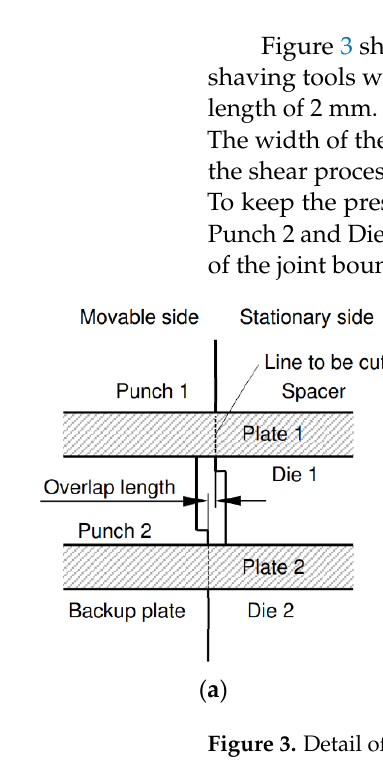
Figure 2. Impact joining device: ( a ) Cross-sectional schematic; ( b ) General view and drop weight.